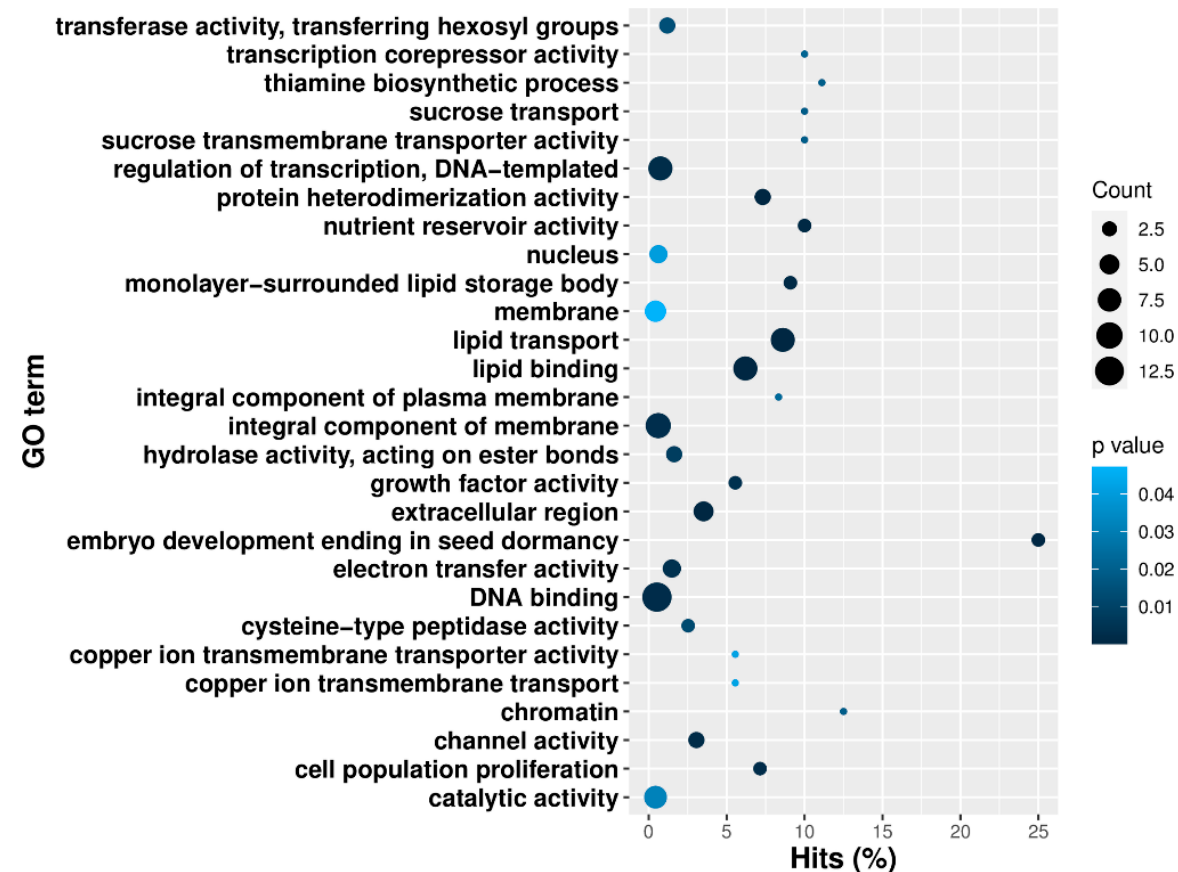
Figure 4. Gene ontology enrichment of the significantly upregulated genes in Coker312 in the EC cells. We also examined the expression profiles of genes known to have a role in somatic embryogenesis, such as BBM , WUS , LEC1 , WUSCHEL-RELATED HOMEOBOX 5 (WOX5) , FUSCA3 (FUS3) , and several other genes [26]. The genes with the sharpest fold changes were Gohir.D13G136000.1( LEC1 − 1 ), Gohir.A13G132600.1( LEC1 − 2 ), Gohir.D07G237600.1( FUS3 − 2